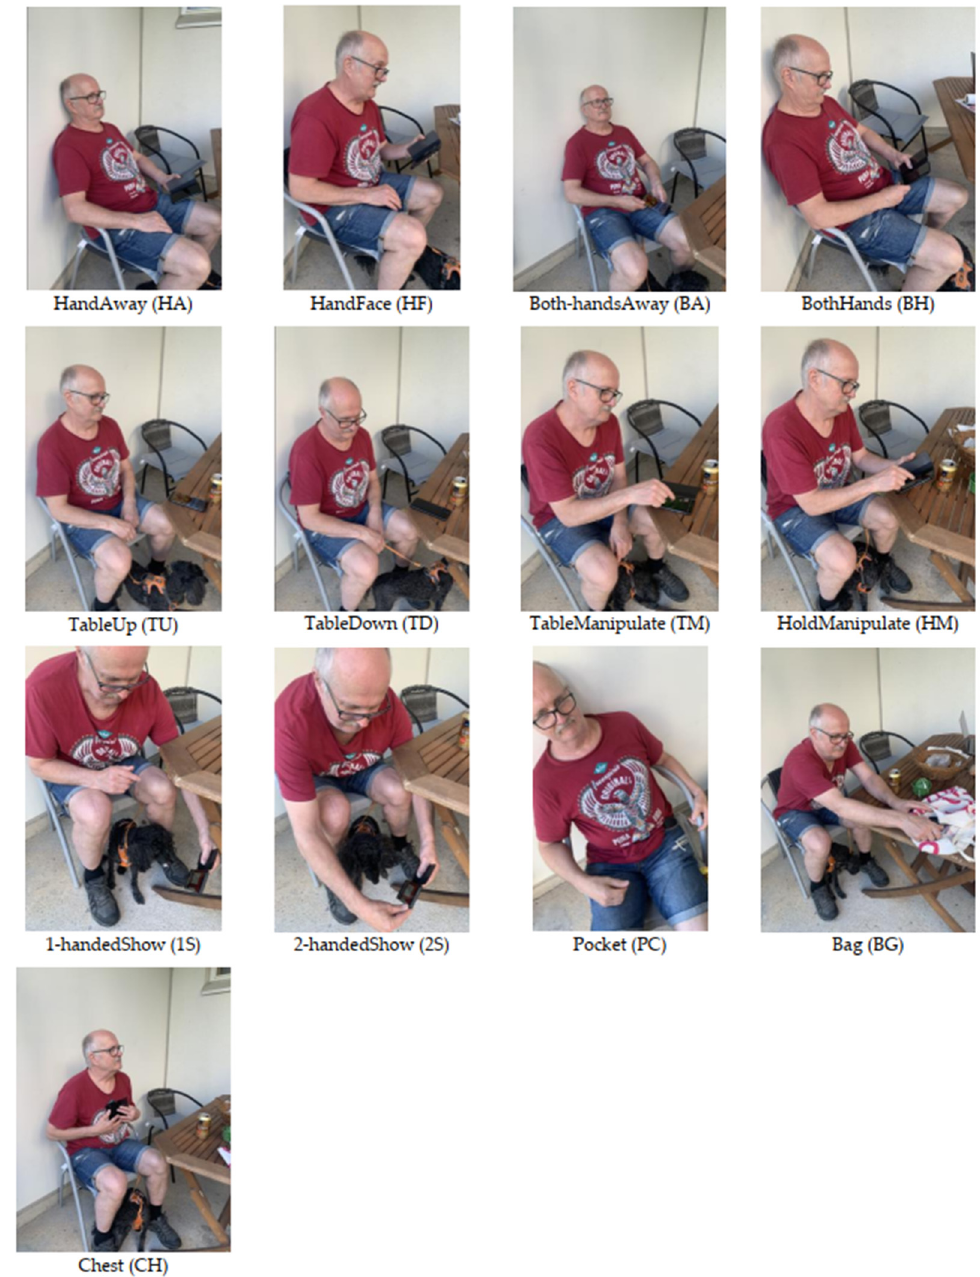
Figure 2. The order of the smartphone positions here does not reflect any assumed order in strength of smartphone engagement they might be embodying 3